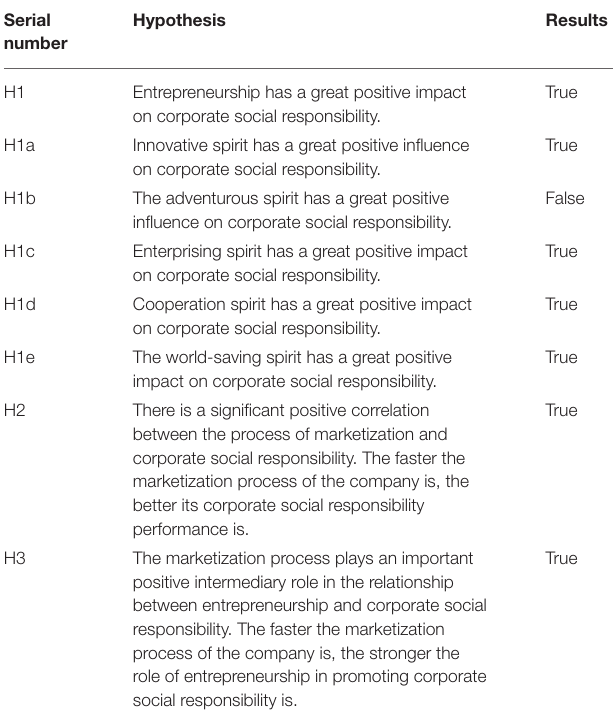
TABLE 5 | Test results of the proposed